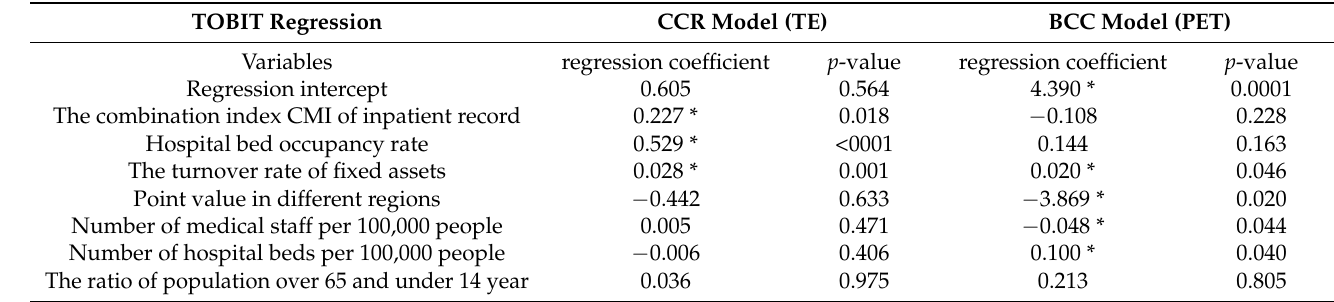
Table 9. The TOBIT regression results of the DEA CCR and BCC